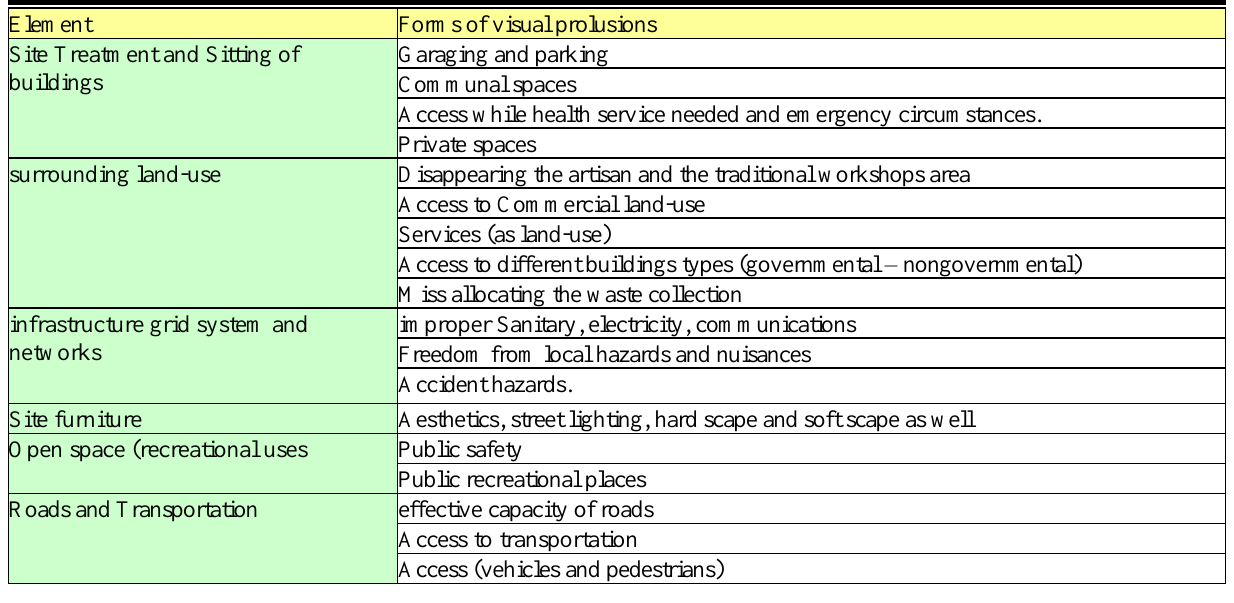
Table 1. Visual pollution elements and forms in the old district